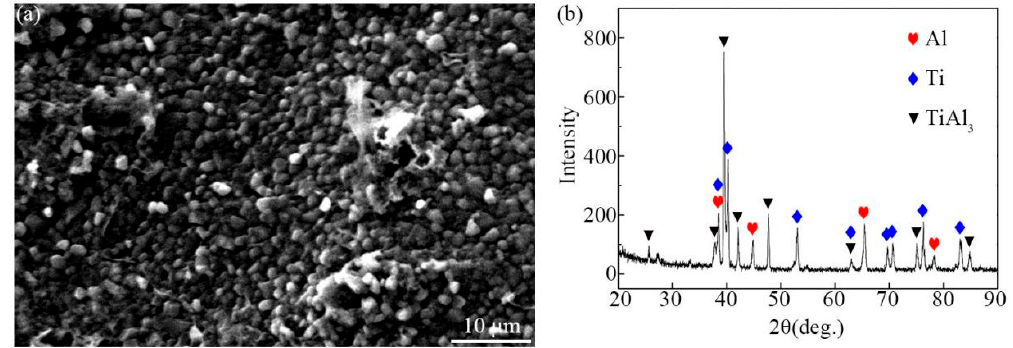
Figure 4. Fracture morphology of samples annealed for 4 h at 873 K ( a ) and XRD pattern taken from the fracture surface ( b